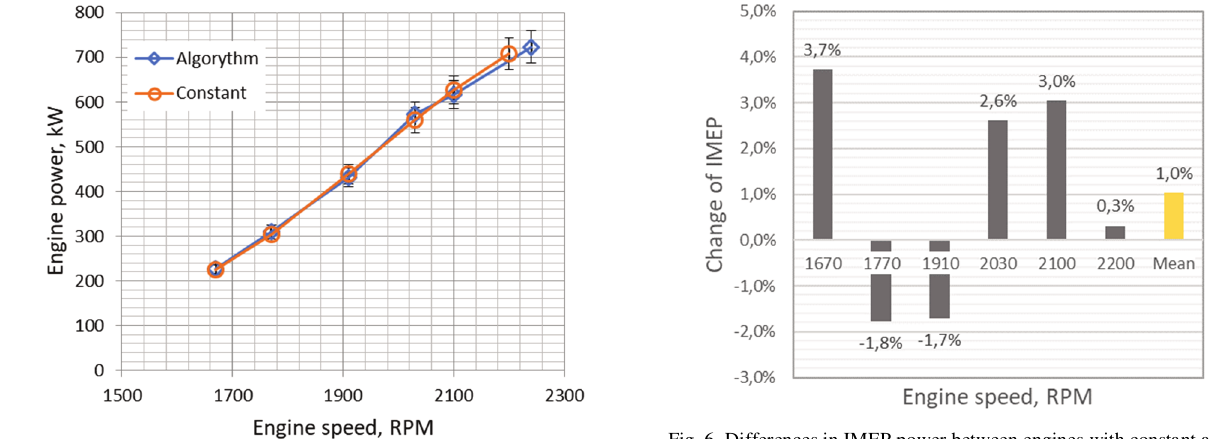
Fig. 6. Differences in IMEP power between engines with constant and variable ignition advance angle